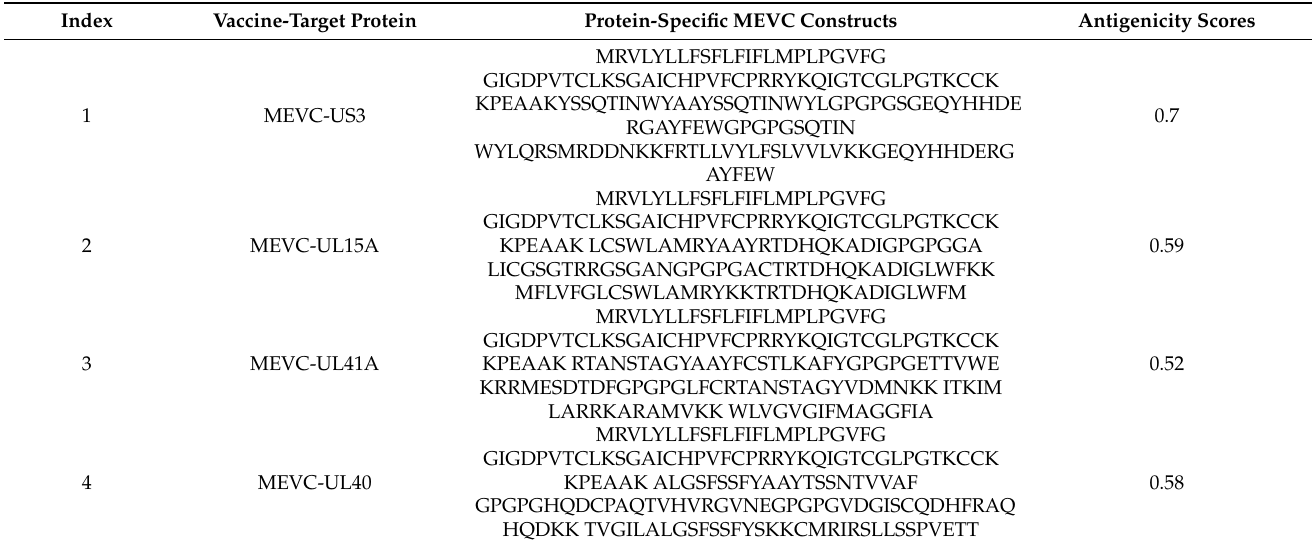
Table 2. Shows the full-length designed MEVCs against the four highly antigenic proteins from